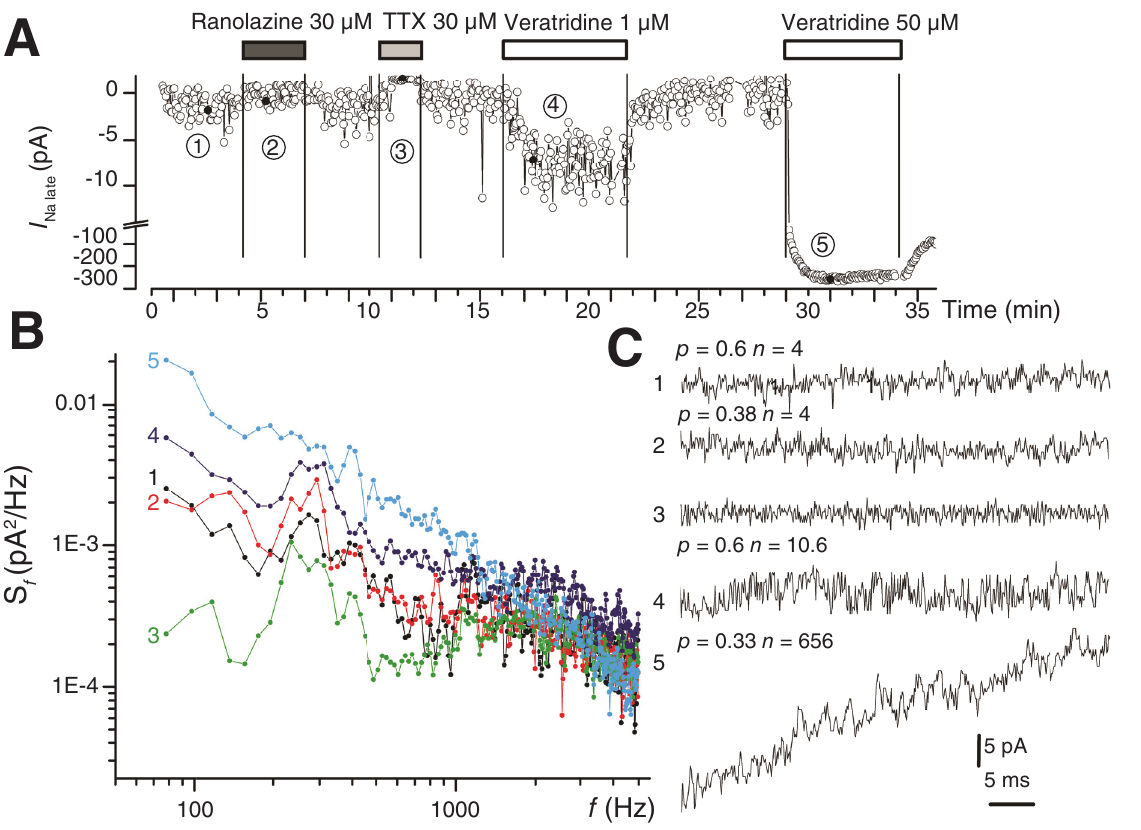
Figure 3. The late Na + current presents fluctuations due to the opening and closure of individual channels. A . Time course of a typical experiment in Nav1.5-expressing cells showing the effects of ranolazine 30 μM, TTX 30 μM, and veratridine 1 μM on I transforms of multiple traces recorded in different conditions in the experiment shown in A : 1. initial control; 2. ranolazine 30 μM; 3. TTX 30 μM; 4. veratridine 1 μM; 5. veratridine 50 μM. C . Fluctuation analysis of individual traces recorded during the five distinct periods shown in A allowed the distinction of individual channel gating events and the computation of the average open probability p and the average number of channels n for each